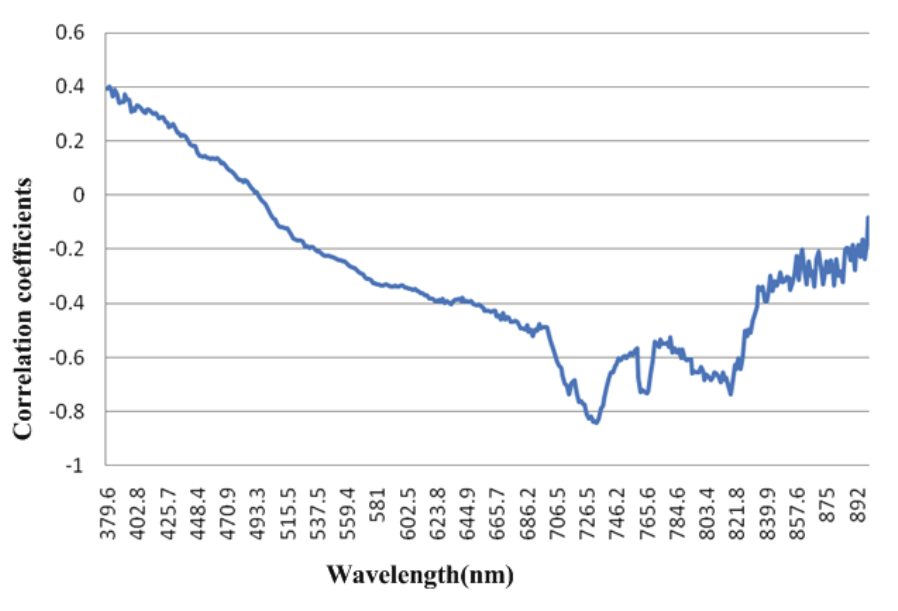
Figure 4. The curve of correlation coefficients between reflectance and Chl- a concentration.